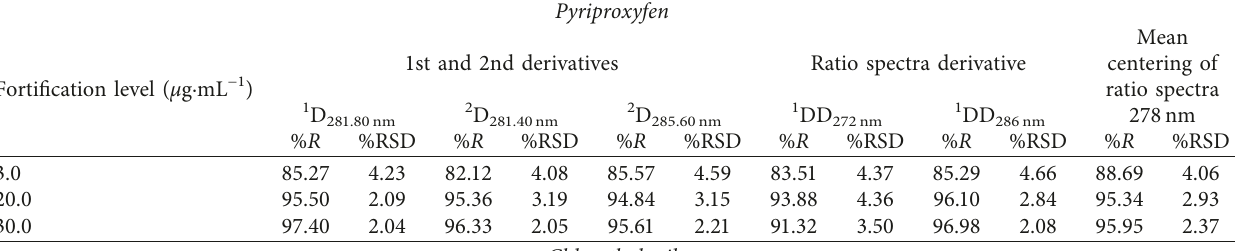
Table 4: Percentage mean recovery of pyriproxyfen and chlorothalonil in real cabbage samples by proposed